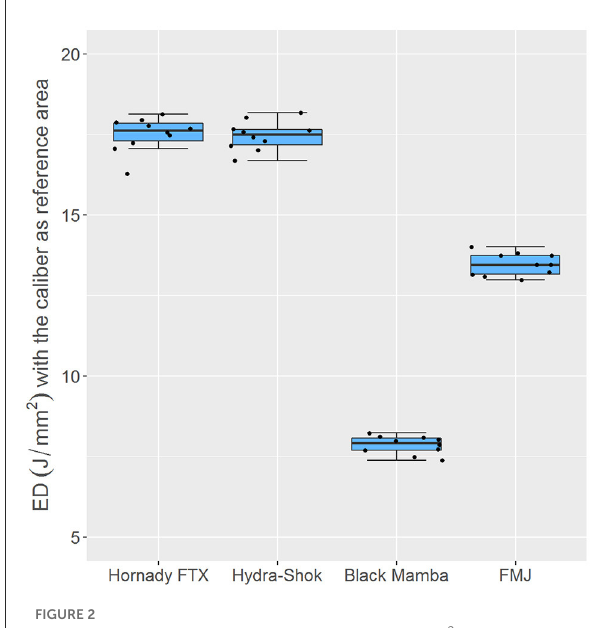
FIGURE2 Boxplots of the calculated energy densities in J/mm 2 for the individual bullet types. The Hornady FTX and the Hydra-Shok demonstrated almost two and a half times more energy density than the Black Mamba . The energy density of the FMJ was almost